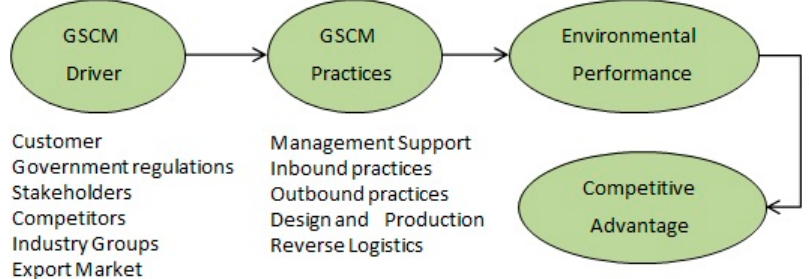
Figure 1. The causal relationship between green supply chain management (GSCM) Drivers, GSCM Practices, Environmental Performance, and Competitive Advantage.